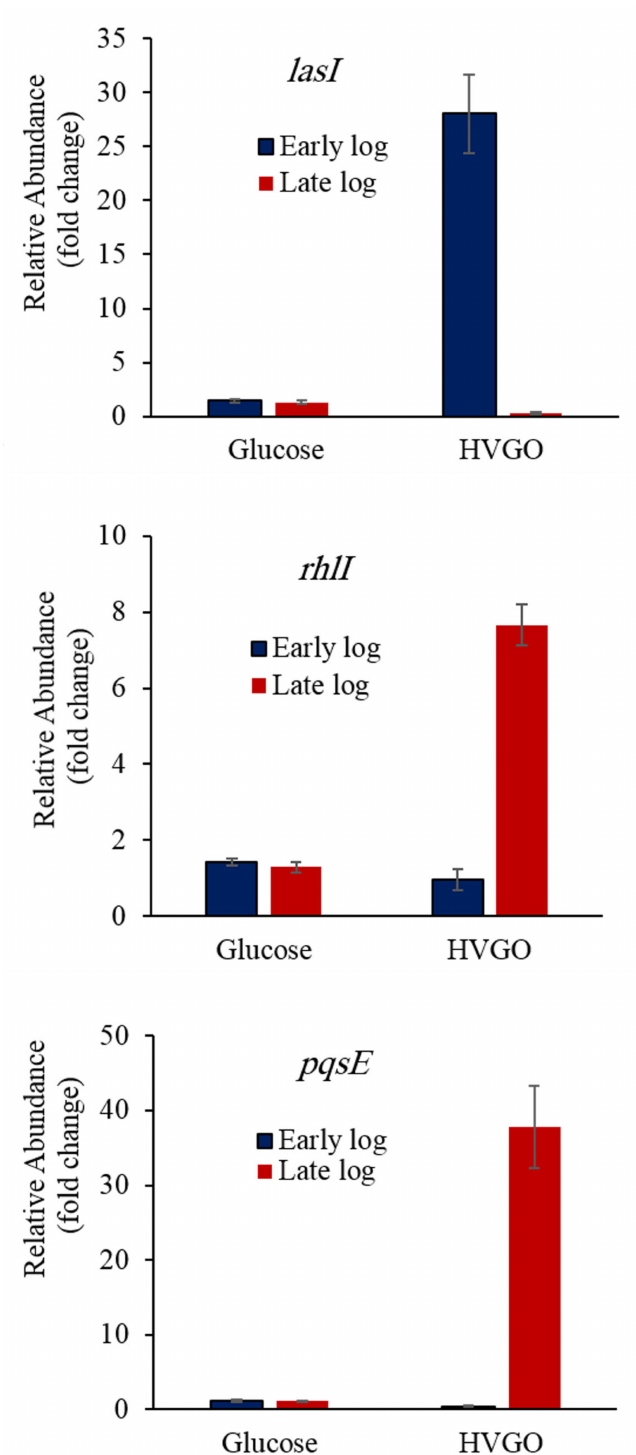
Figure 5. Relative expression of the quorum sensing genes in the glucose and HVGO cultures of strain AK6U during the early and late log phases of growth. Error bars represent standard error (number of replicates =